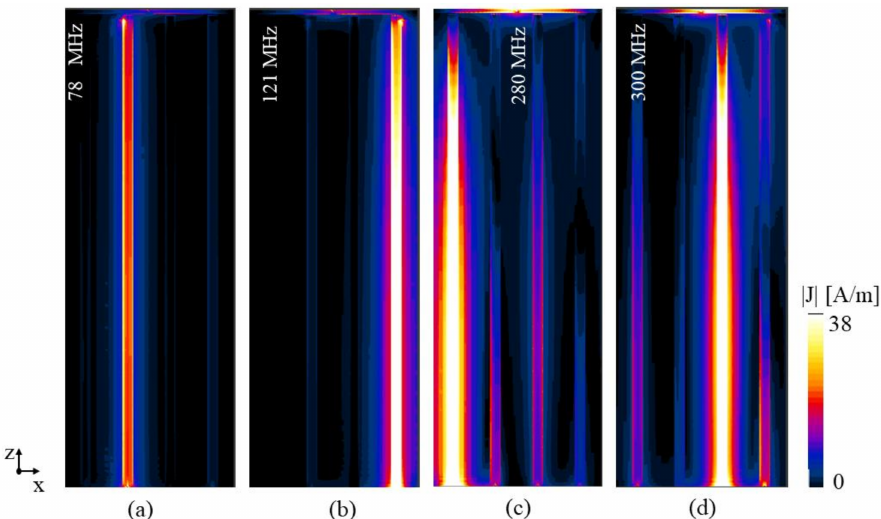
Figure 9. The surface current density distribution of the z-x plane at ( a ) 78, ( b ) 121, ( c ) 280 and ( d ) 300